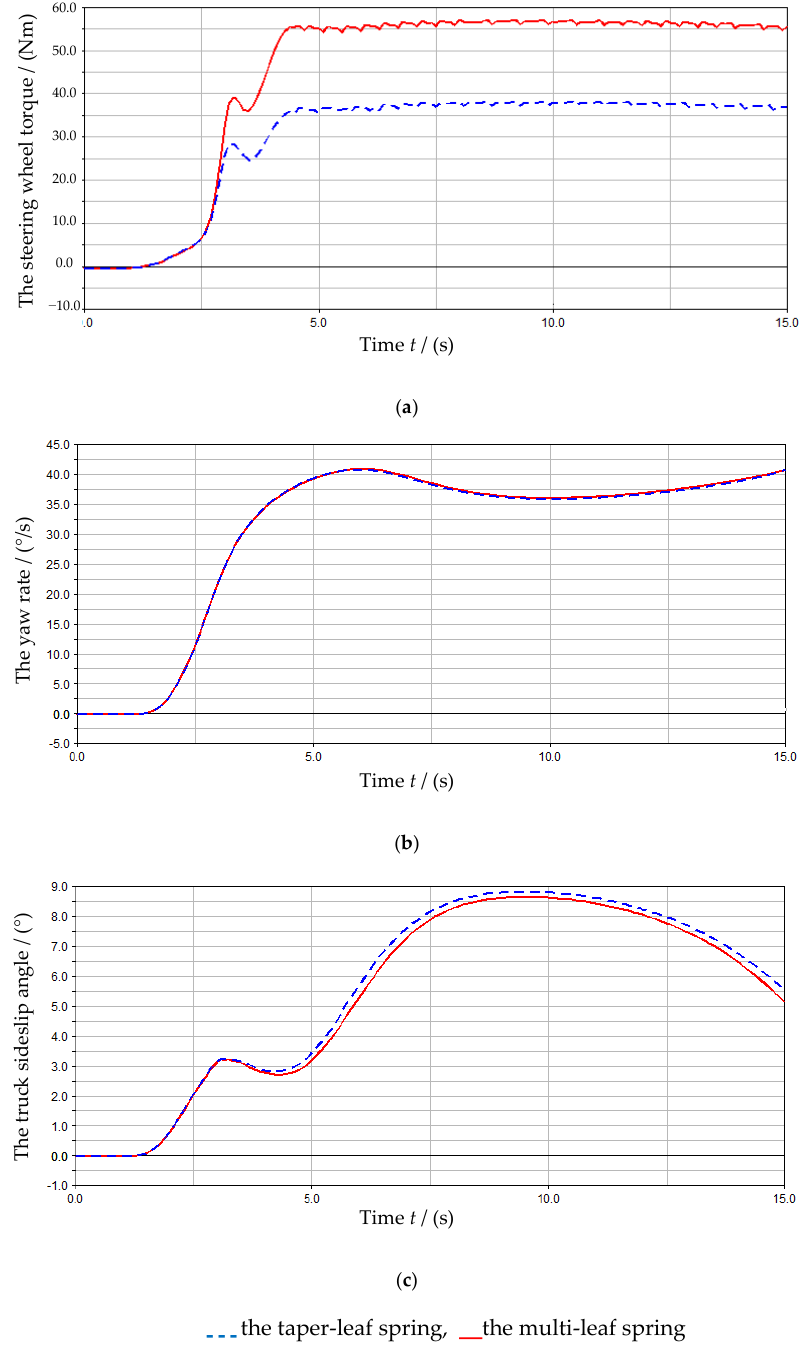
Figure 10. A comparison of the simulated dynamic responses obtained from the drift tests: ( a ) The steering wheel torque, ( b ) the yaw rate, and ( c ) the truck sideslip angle.